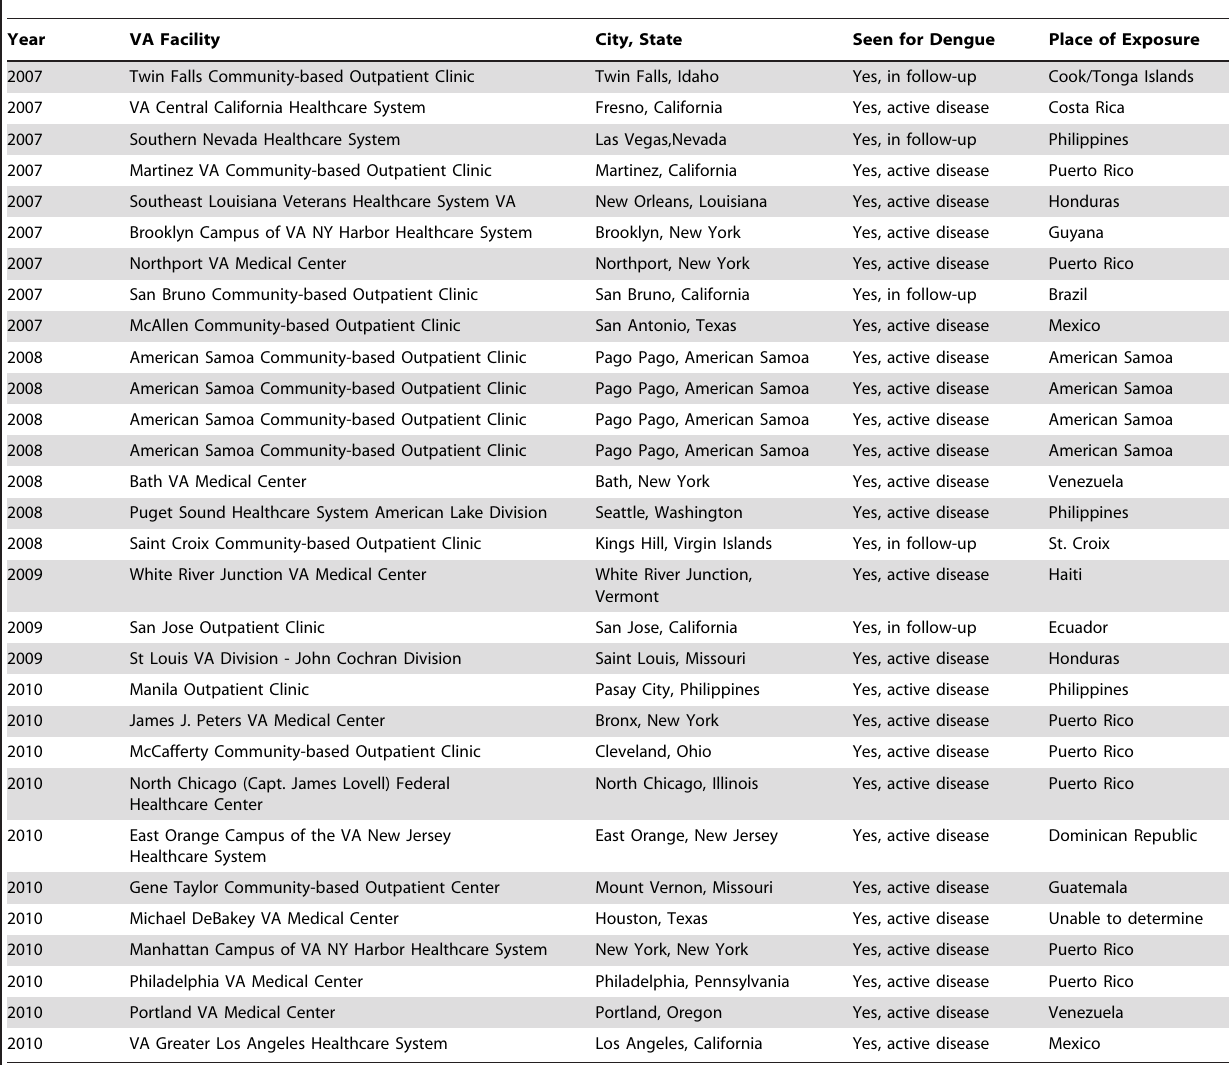
Table 1. Patients with dengue diagnosed outside of Puerto Rico and Florida,